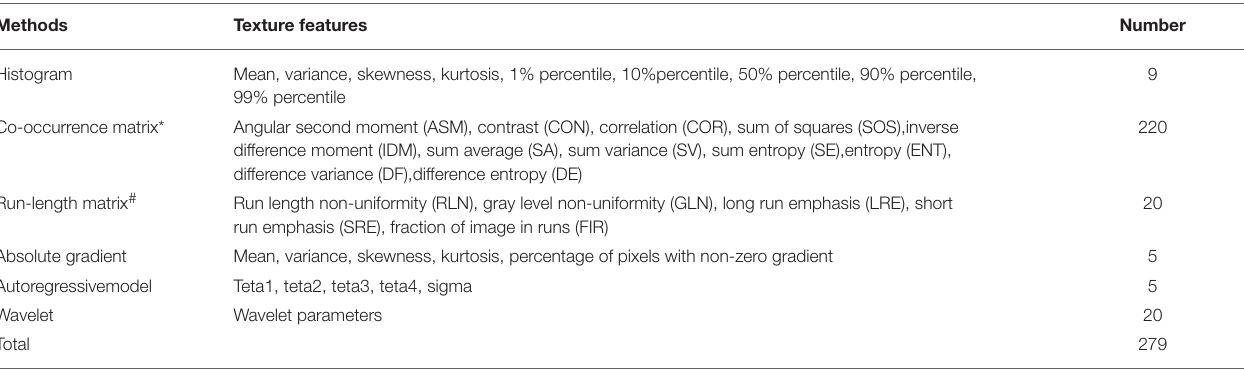
TABLE 2 | The features calculated with MaZda using different texture analysis methods.